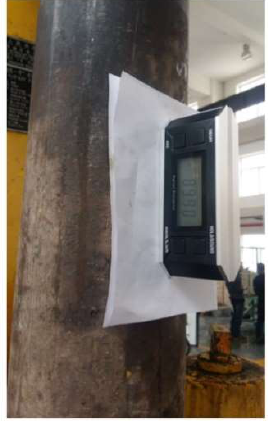
Figure 12. Inclination test.